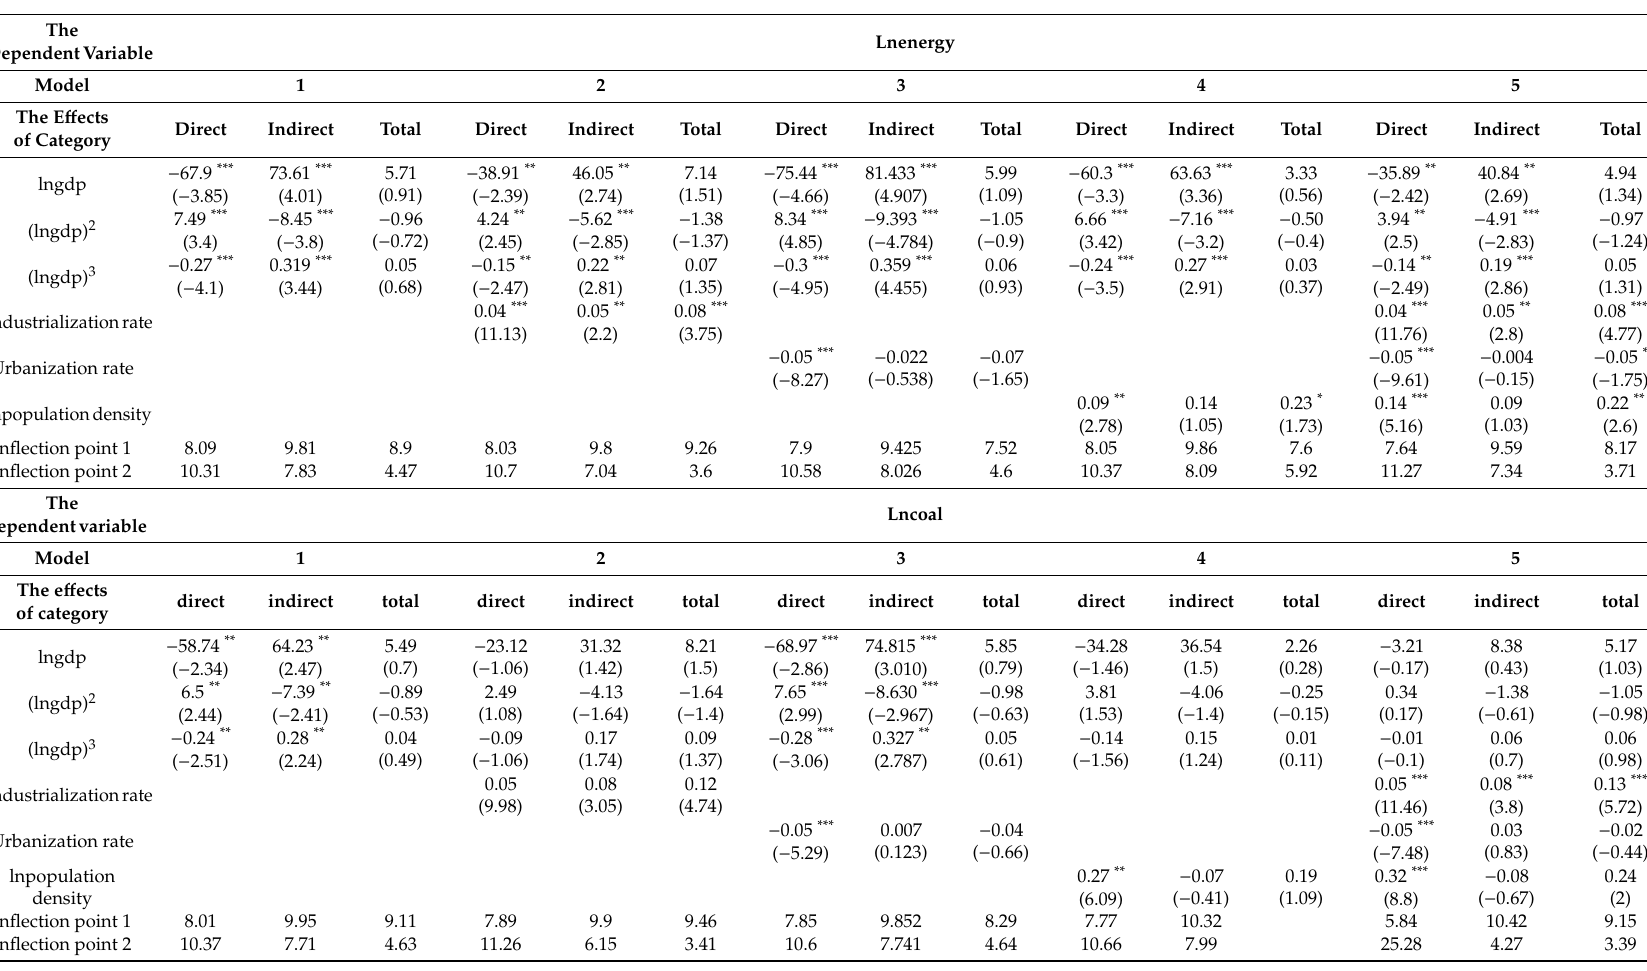
Table 10. Direct e ff ect, indirect e ff ect, and total e ff ect of total energy consumption, coal consumption, oil consumption, and gas consumption in spatial Durbin model. The